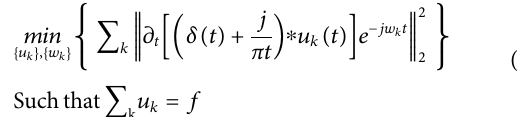
FIGURE 3 | Pseudocode for the procedure of generating the training and testing data.